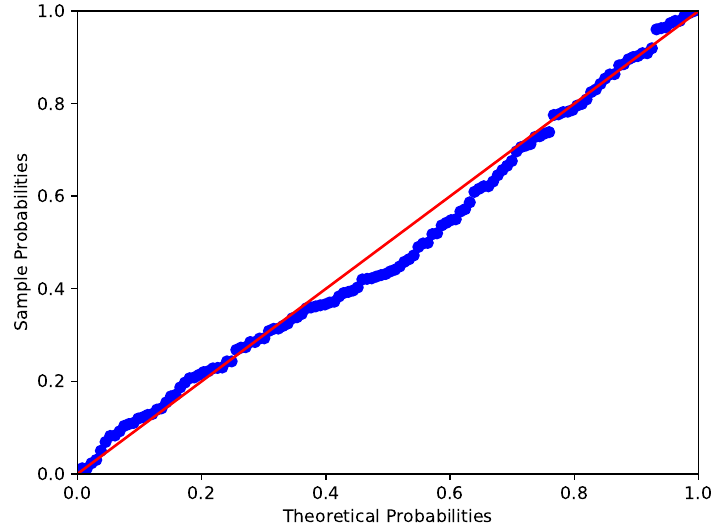
Figure 3. P-P plot of carbon fibers’ strength data (Red line and blue line respectively denote the theoretical probabilities and sample probabilities).